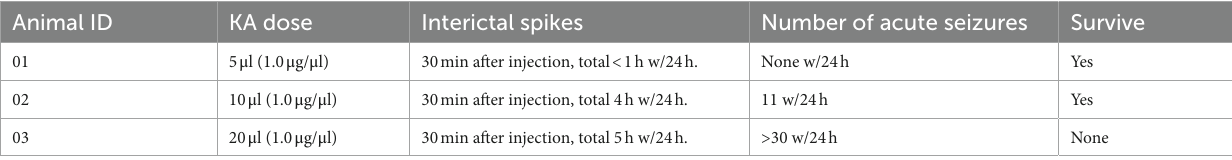
TABLE 1 Responses of three kainic acid (KA) doses in 0–24 h after injection. Animal ID KA dose Interictal spikes Number of acute